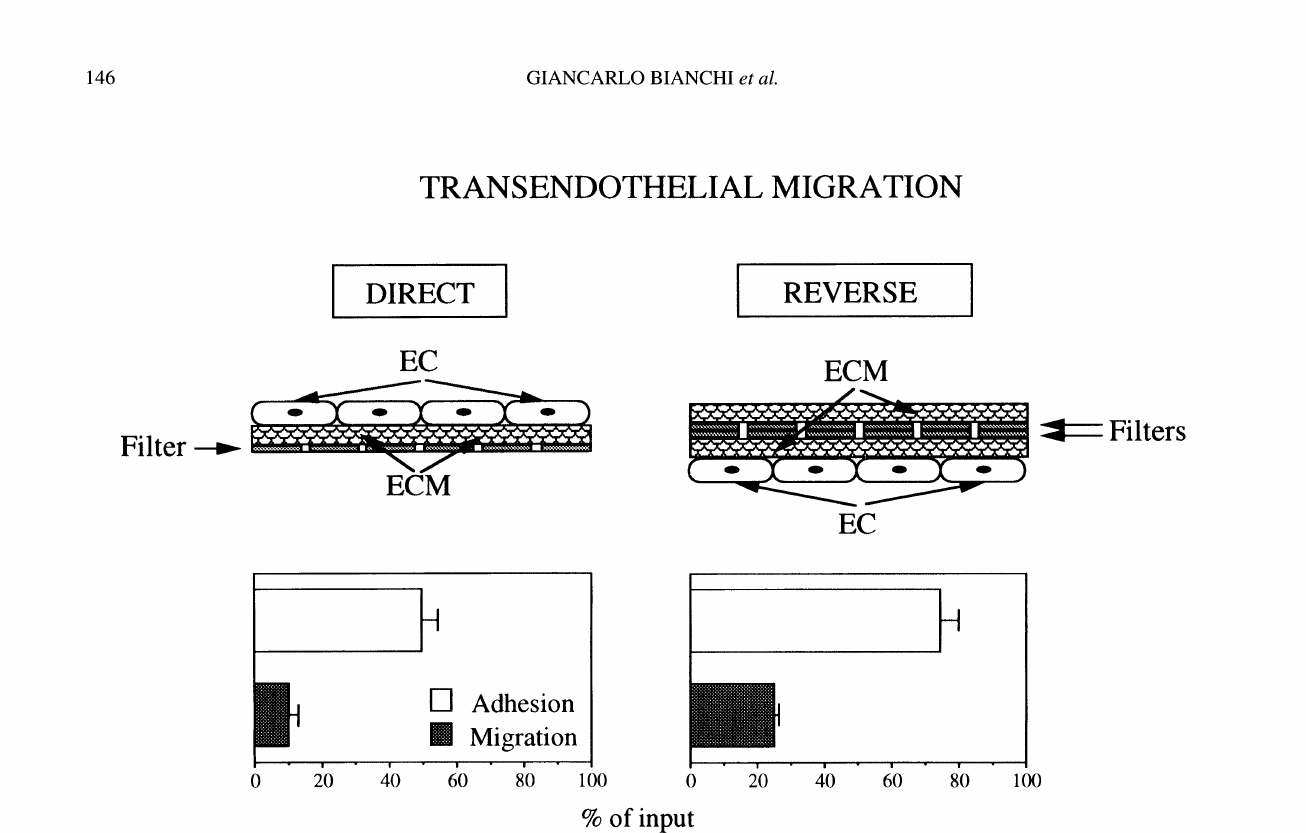
FIGURE 2 Trans-endothelial migration of DC. In the direct transmigration (A), a porous policarbonate filter was coated with a monolayer of EC and placed in modified Boyden chamber. In the reverse transmigration (B) a double filter system was used. The upper filter was coated 51 with an ECM and the lowe, filter was coated with a monolayer of EC placed upside down. -Cr-labeled DC were seeded in the upper com- partment of the chamber and co-incubated with EC monolayer for lh at 37C. Results are expressed as % of adherent and transmigrated cells mean_+SEM of three replicates